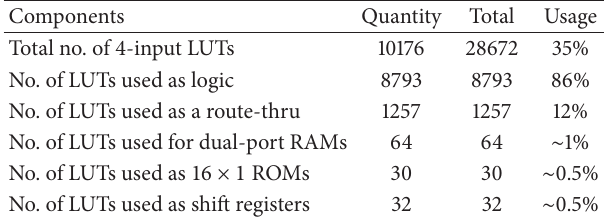
Table 13: LUT utilization of